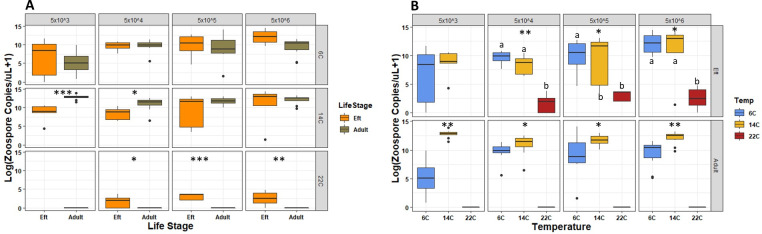
Boxplots showing log-transformed Bsal zoospore copies/uL+1 estimated at necropsy from swab samples tested via qPCR.Boxplots shown represent each zoospore exposure dose (5x103-6 per 10 mL) for each life stage (A) and temperature (B). Boxplots faceted by temperature and exposure dose are colored brown and orange in (A) representing adult and eft life stages, respectively. Boxplots faceted by life stage and exposure dose are colored blue, yellow and red in (B) representing 6, 14 and 22°C exposure temperatures, respectively. Significant Wilcoxon tests between exposure temperatures for each exposure dose are shown in (A) (ns = not significant, * = P<0.05, ** = P<0.01, *** = P<0.001). Significant Kruskal-Wallis tests are indicated in (B) (ns = not significant, * = P<0.05, ** = P<0.01, *** = P<0.001). Temperatures with unlike lowercase letters are significantly different.